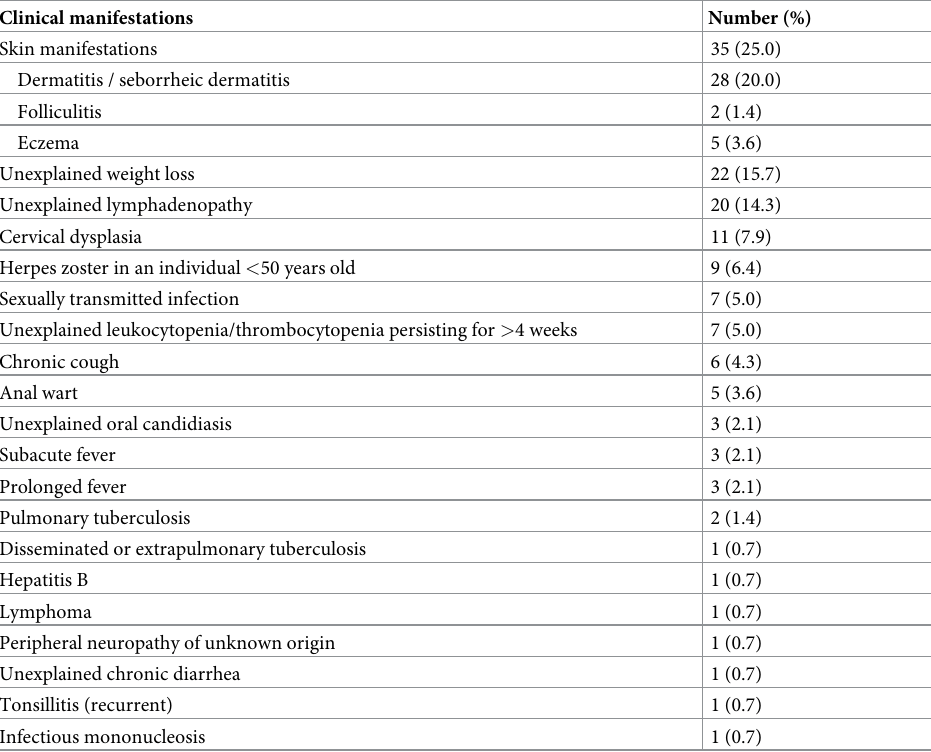
Table 2. Numbers of clinical indicator diseases that were missed in the